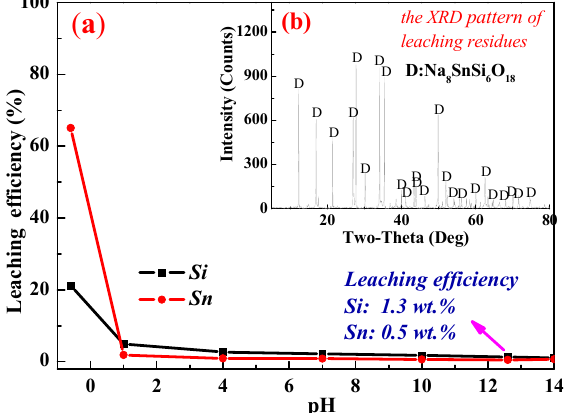
Figure 11. The leaching efficiency Si and Sn of the synthetic Na 8 SnSi 6 O 18 . ( a ) leaching efficiency Si and Sn, ( b ) XRD pattern of leach residues.